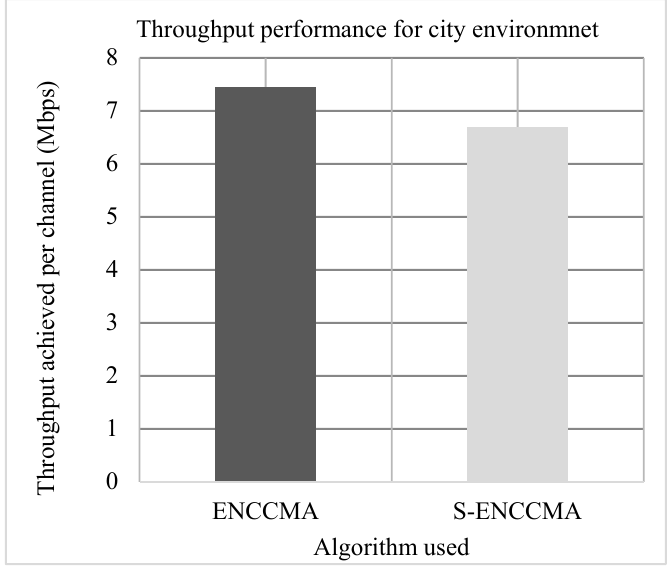
Figure 3. City environment throughput performance for varied vehicles. Throughput performance for highway environmnet